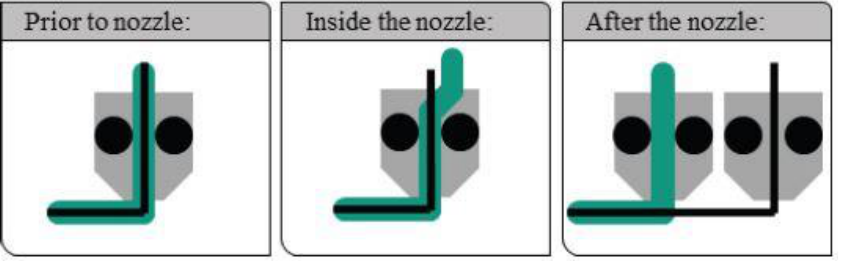
Figure 12. Methods of continuous fiber implementation based, grey areas are the nozzles, green strings are the extruded thermoplastics, and the black strings are fibers. Reprinted with permission from [124], 2017, Elsevier, Amsterdam, The Netherlands.